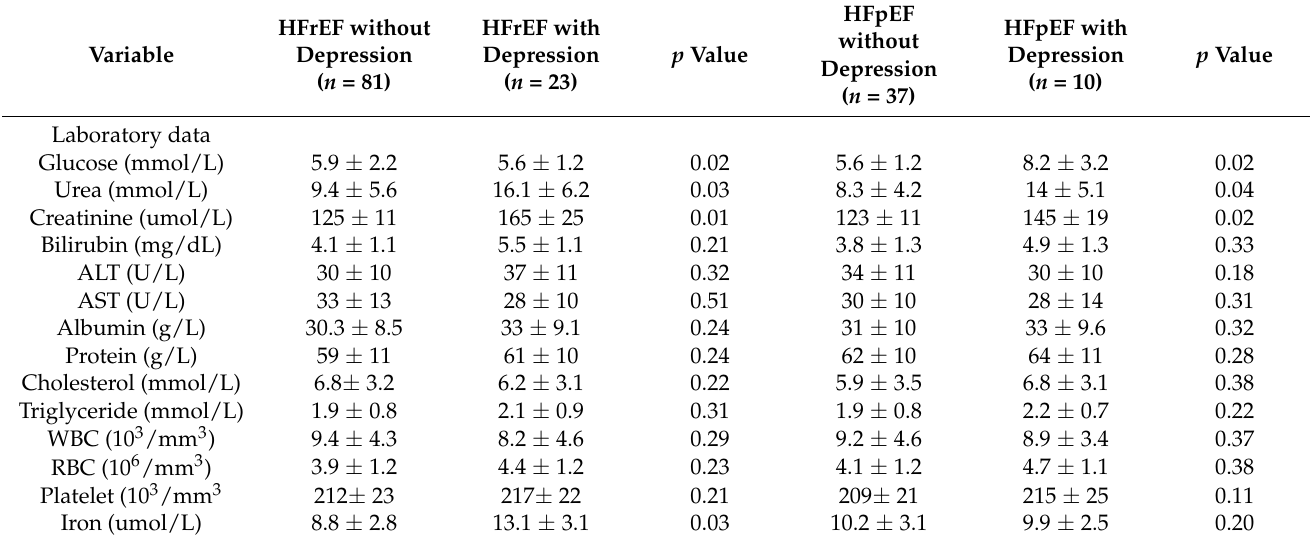
Table 2. Laboratory data between HF patients with and without depression according to EF.